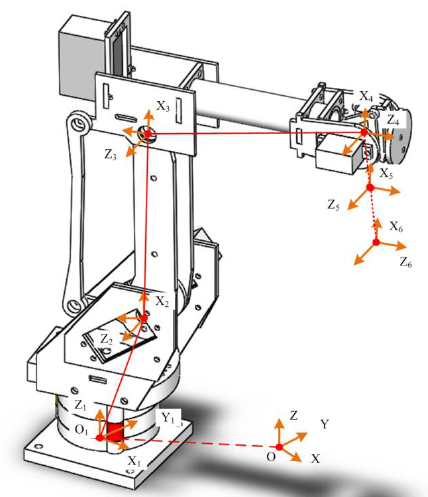
Figure 5. Kinematics modeling of the manipulator. Table 2. Degree of joints in D-H